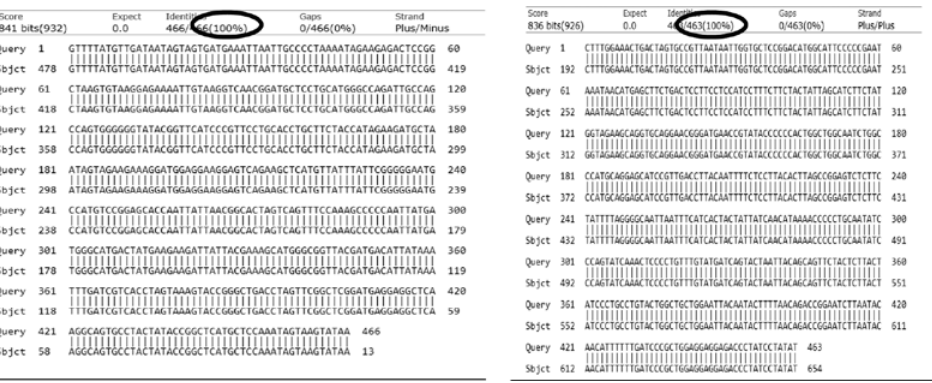
Fig.2. NCBI BLASTn analysis showing 100% identity between COX1 sequence from CMT case 1 and the reference sequence mn542345.1 from Canis lupus familiaris isolate 38 cytochrome c oxidase subunit 1 (COI) gene, partial